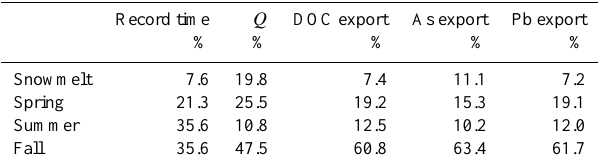
Figure 7. Top three panels: concentration record and instantaneous loads of DOC, Pb and As at the bog outlet. Bottom panel: annual records of bog water level, precipitation and discharge. Table 1. Seasonal distribution of discharge, DOC, As and Pb export fluxes at the Odersprung catchment.